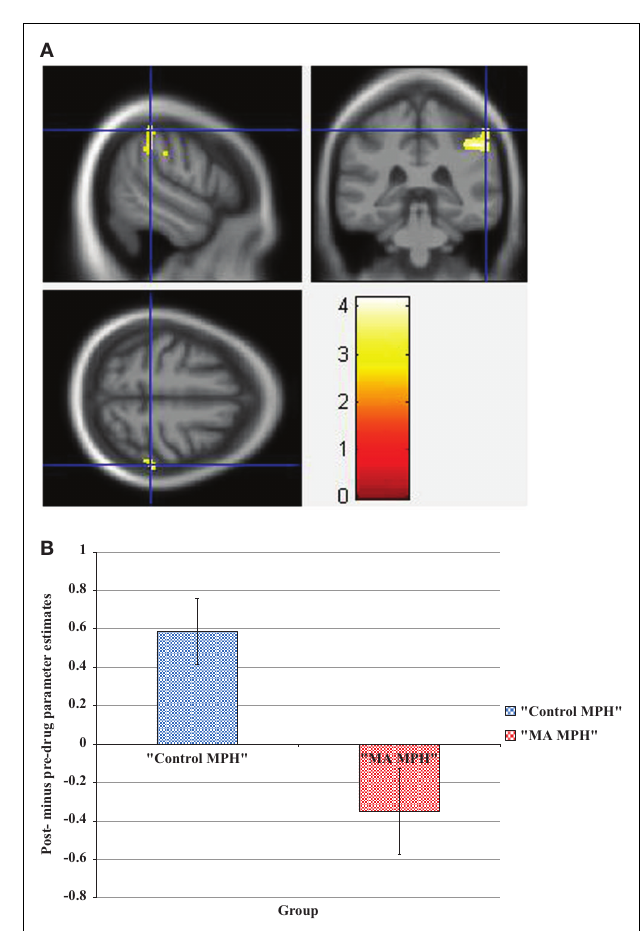
FIGURE 4 | (A)Whole-brain 2 × 2 between-subjectANOVA results for the incongruent condition showing post- minus pre-drug “Control MPH” > “MA MPH” group differences in activation of the right inferior parietal lobule [peak voxel MNI co-ordinates (mm): (56, − 36, 54); T 29 = 3.34, p < 0.05 cluster-corrected], and (B) Plot of the mean ± standard error parameter estimates representing the percentage blood-oxygen-level-dependent signal change post- compared to pre-drug administration within the right inferior parietal lobule .The scale represents the color (from red to yellow) of the cluster corresponding to the increasing t -statistic.The structural image represents the IXI550 average normal brain which has been registered to the MNI152 space with corresponding inferior–superior